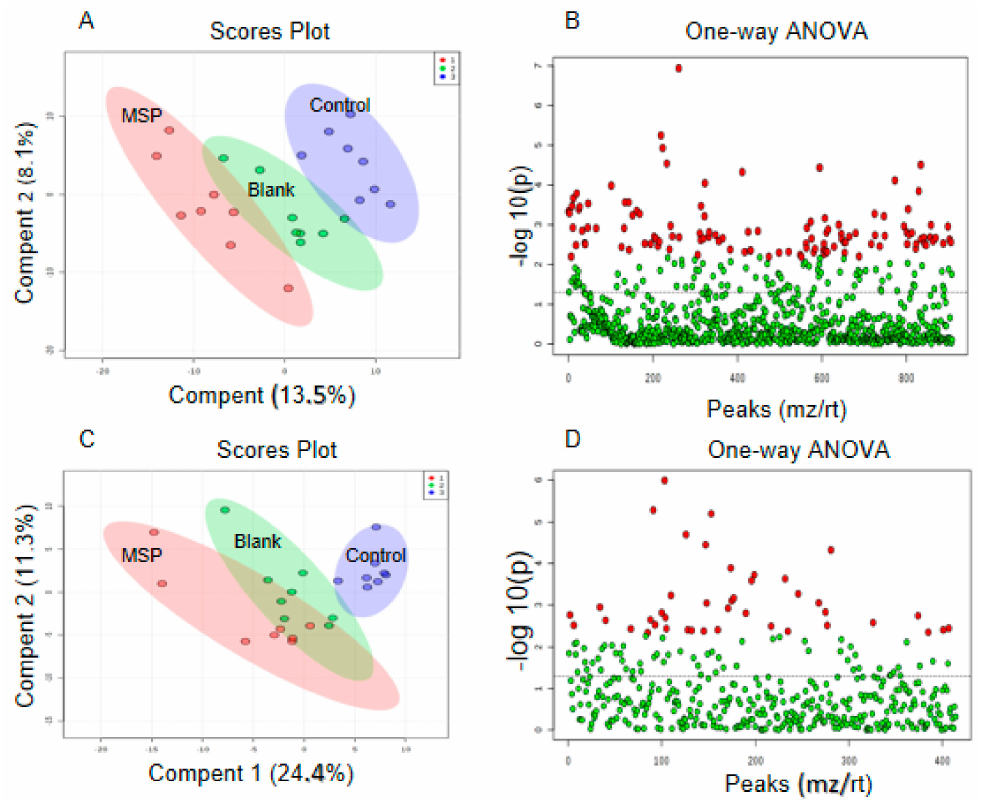
Figure 7. Score plot of plasma metabolomic profiling of three groups mice in positive ion mode ( A ) and negative ion mode ( C ). A total of 119 di ff erential ions were screened by “adjusted p -value < 0.05, Fold change > 2” in positive ion mode ( B ). A total of 42 di ff erential ions were screened by “adjusted p -value < 0.05, FC > 2” in negative ion mode ( D ).